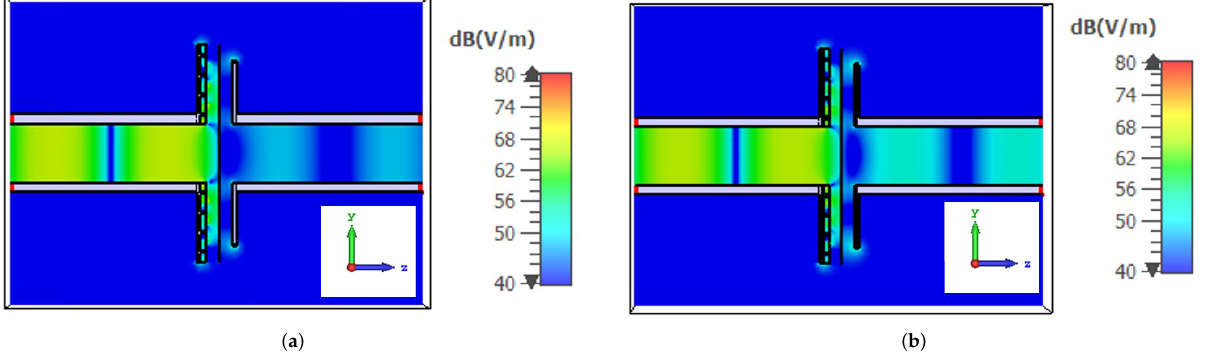
Figure 4. Field distribution at the discontinuity: ( a ) field distribution with the calibration sheet (surface impedance value equal to 50 Ω /sq); ( b ) field distribution using a sheet with a surface impedance equal to 100 Ω